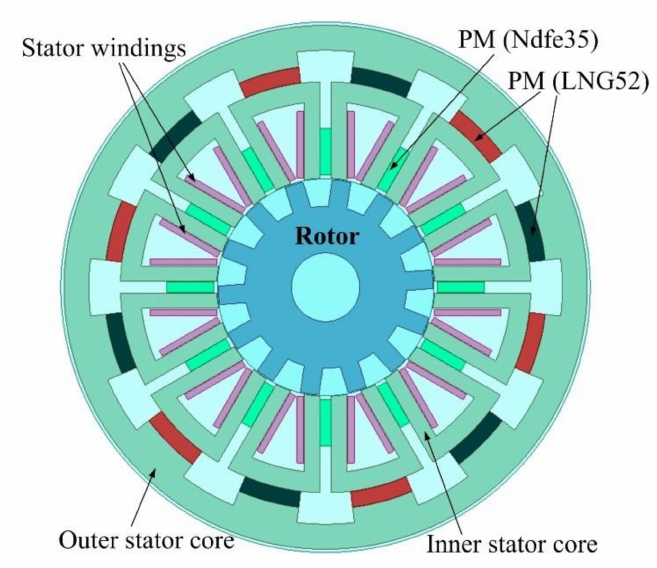
Figure 1. The structure of the VFMPM